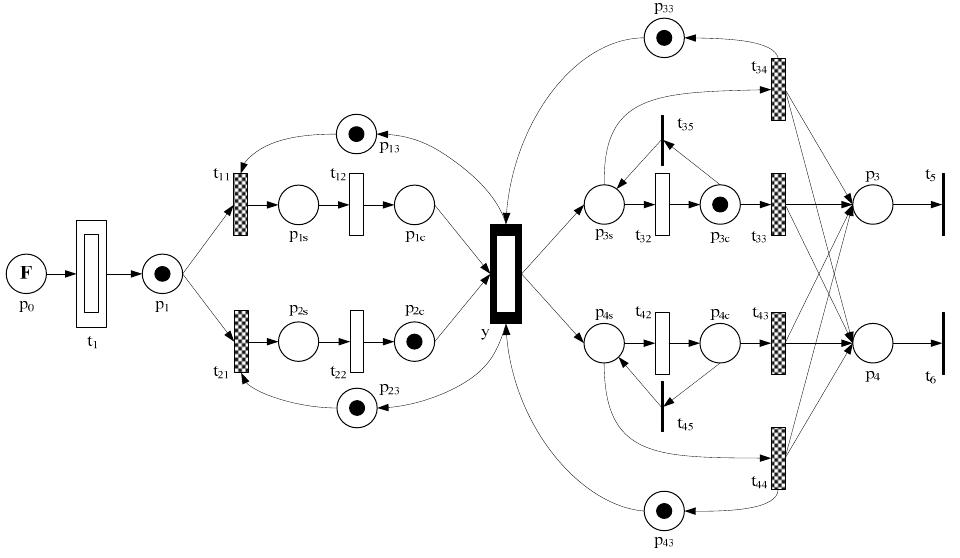
Figure 5. PN model of the whole system.